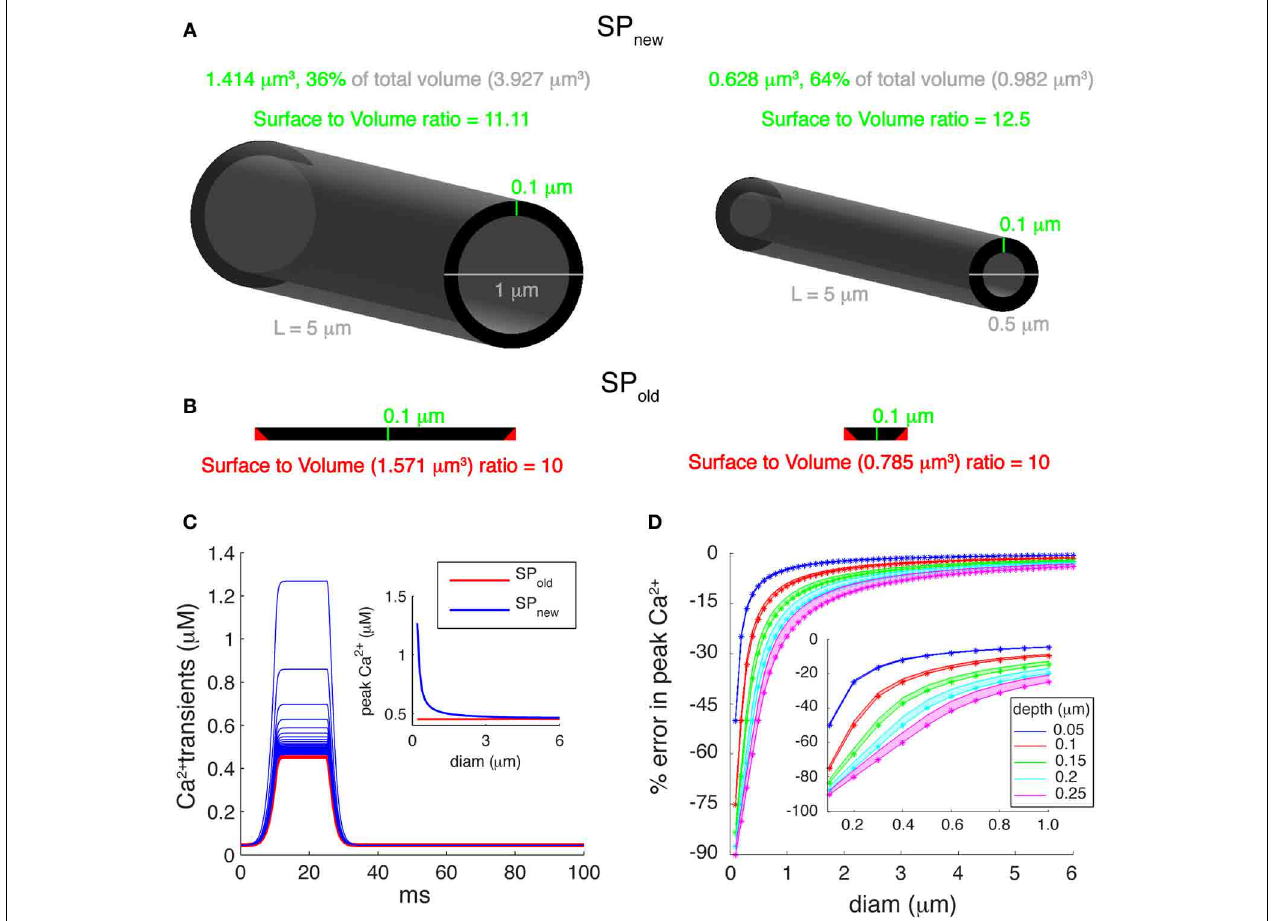
FIGURE 3 | Errors introduced by incorrect submembrane volumes of single pool models. (A) Comparison between cylindrical dendritic compartments with diameters of 1 μ m (left) and 0.5 μ m (right) with submembrane shells with a depth of 0.1 μ m. A correct implementation of the volume of the submembrane shell representing the single Ca 2 + pool (SP new mechanism) results in a SVR that depends on the compartment diameter. (B) For the same compartments using the SP old mechanism results in volumes that are too large and have a constant SVR. The cross-sectional area of each compartment (black disks shown in A ) is unfolded and drawn to show that the actual volume of the submembrane shell (SP new ) is smaller than the volume used in the SP old mechanism. The red triangles represent extra cross-sectional area included in the volume of SP old . (C) Ca 2 + transients generated using a “ramp-like” voltage command in single compartments with diameters ranging from 0.2 to 6 μ m in steps